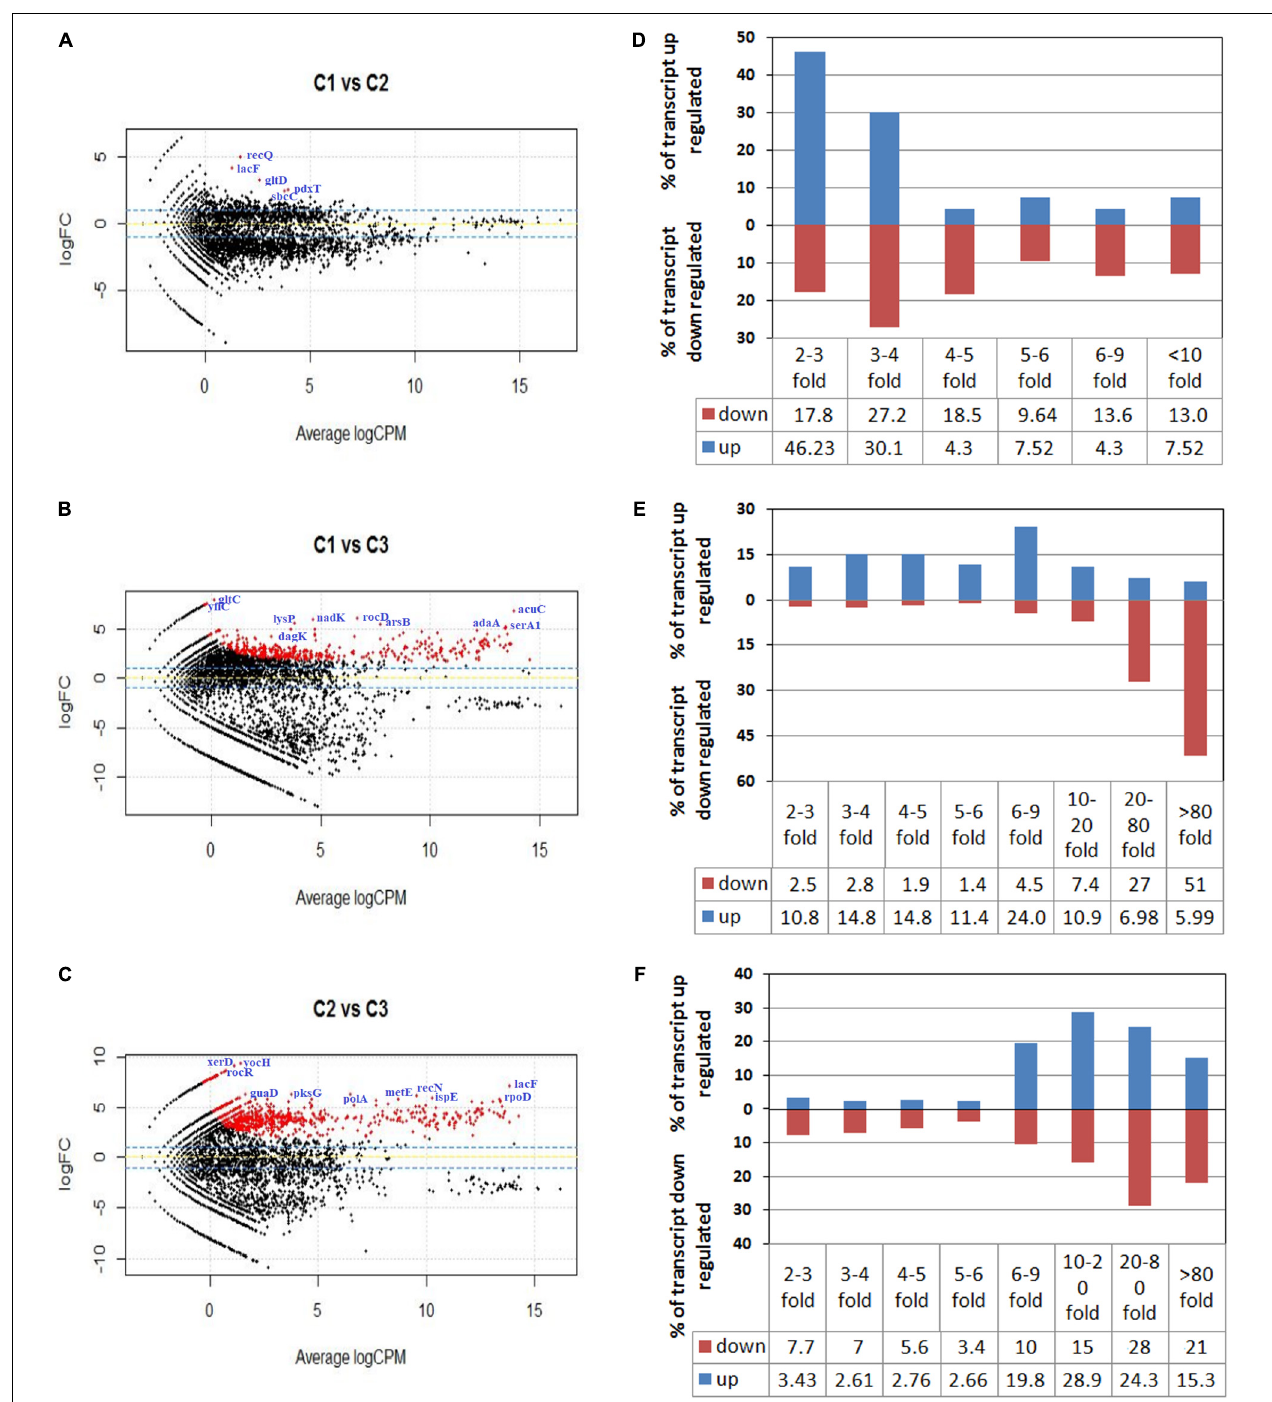
FIGURE 2 | MA plot for differential expression analysis generated by EdgeR. (A–C) Represent the MA plot of the differentially expressed genes (DEGs) when the RNA sequencing data of samples C1 (5% NaCl), C2 (10% NaCl), and C3 (25% NaCl) were compared with each other. Plot A represents the DEGs of C1 vs. C2, while (B,C) plots represent the DEGs of C1 vs. C3 and C2 vs. C3, respectively. Each gene is represented by a black dot. The blue lines represent the log FC ± 1.0 threshold, and the yellow line indicates a log ratio of zero. The dots in the plus direction represent the upregulation and in the minus direction represent the downregulated genes. (D–F) Represent the comparisons of the DEGs of C1 vs. C2, C1 vs. C3, and C2 vs. C3 samples. They represent the percentage of the upregulated and downregulated transcripts in different fold change categories.